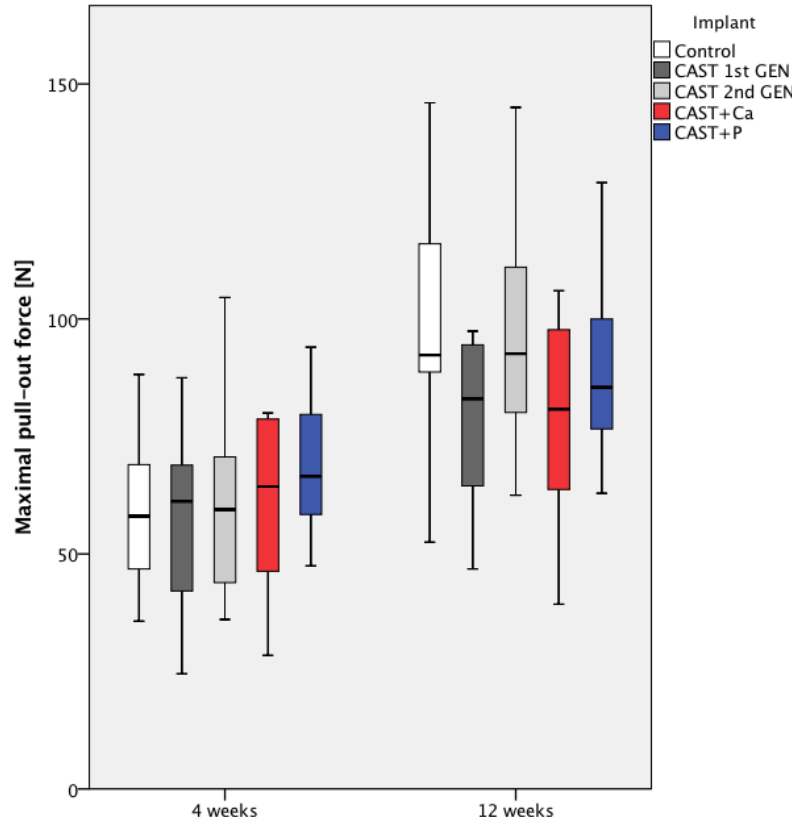
Figure 5. Boxplot of maximum pull-out force after 4 and 12 weeks. The 25th and the 75th percentile as well as the median are indicated by the box, while the whiskers depict maximum and minimum values. No significant difference between all 5 groups was observed (p > 0.05, Kruskal–Wallis test). Analysis of the histological sections showed a thin layer of osseous tissue covering a large part of the implant surface on the section of all five groups. Examples of histologic sections of both cast and machined Ti6Al4V implants are depicted in Figure 6.